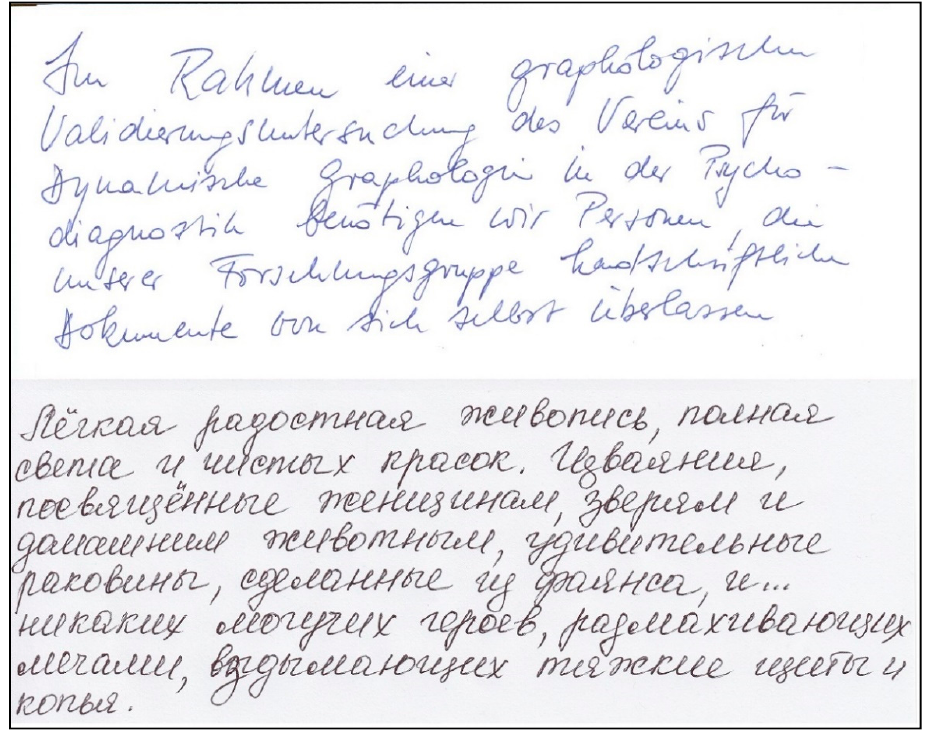
Figure 1. Handwriting samples with high responsiveness.